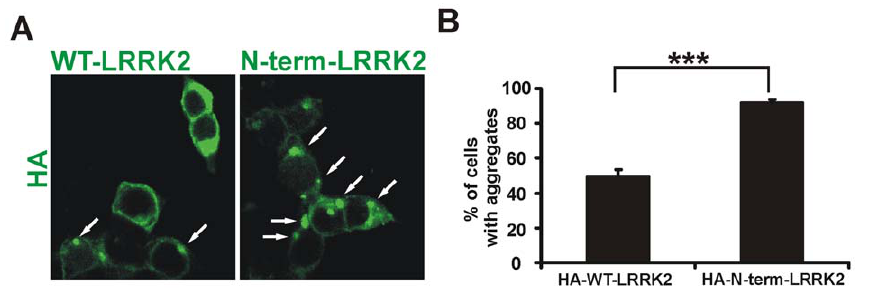
Figure 3. HA-tagged LRRK2 constructs show same pattern of aggregation. ( A ) SH-SY5Y cells were transfected with LRKK2 constructs and immunostained with anti-HA antibody after 16 hours. Arrows point to intracellular aggregates. ( B ) Quantitation of HA-LRRK2 cells with aggregates; Ninety-two percent of N-term-HA-LRRK2 cells showed aggregates compared to 49% of HA-WT-LRRK2 cells. Bars represent the average of the mean values from each of three experiments 6 S.E.M. (***P , 0.001, n=3, Student’s t -test).